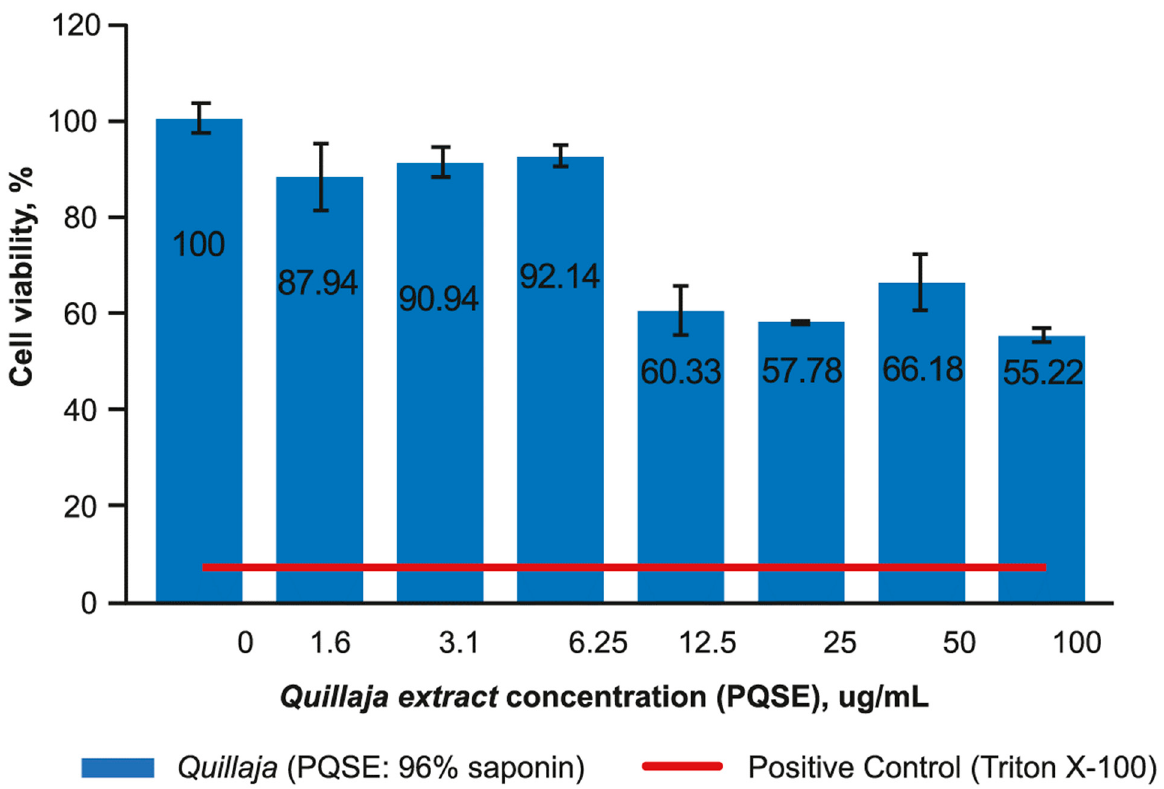
Figure 3. Viability of SHK-1 cells exposed to a High Purified Quillaja saponin Extract (PQSE). The image corresponds to Table 1. cell viability was higher than 90% until doses of 12.5 µ g/mL of the extract (equivalent to 12.0 µ g/mL of saponin). But at levels more than 12.5 ug/mL, the cell viability was reduced to 60%. The cell viability of the Positive Control (Triton X-100) was 39%. The viability was estimated as (Optical density of treated cells, OD)/(OD Control cells) ×